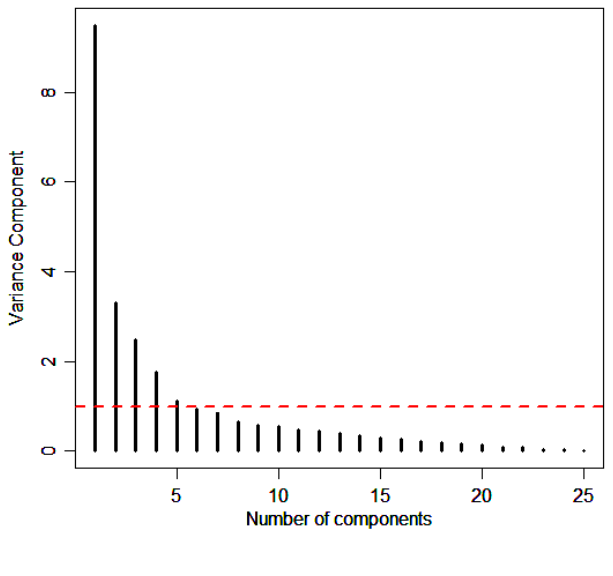
Fig. 2. Scree plot of the number of components in the principal components